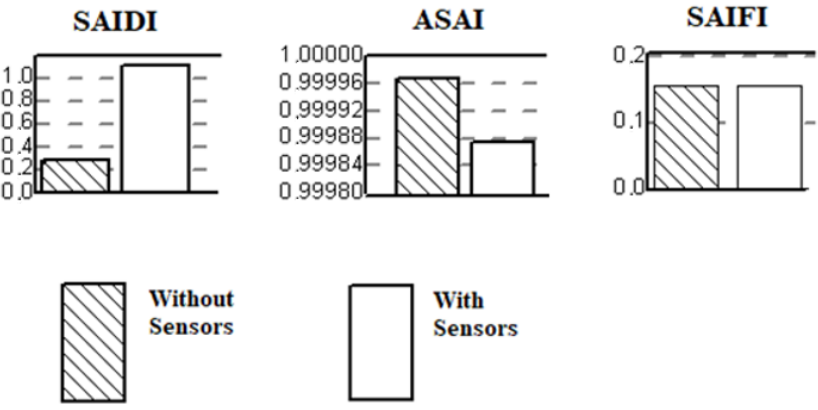
Figure 16. The diagram of system reliability metrics for the entire power distribution network.